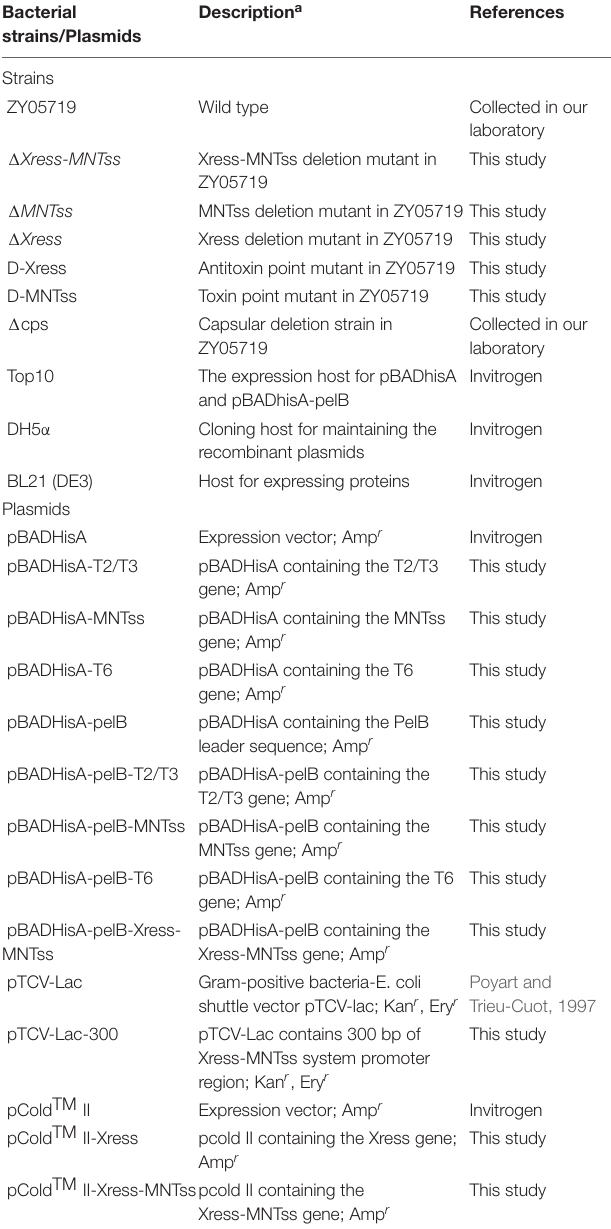
TABLE 1 | Bacterial strains and plasmids used in this